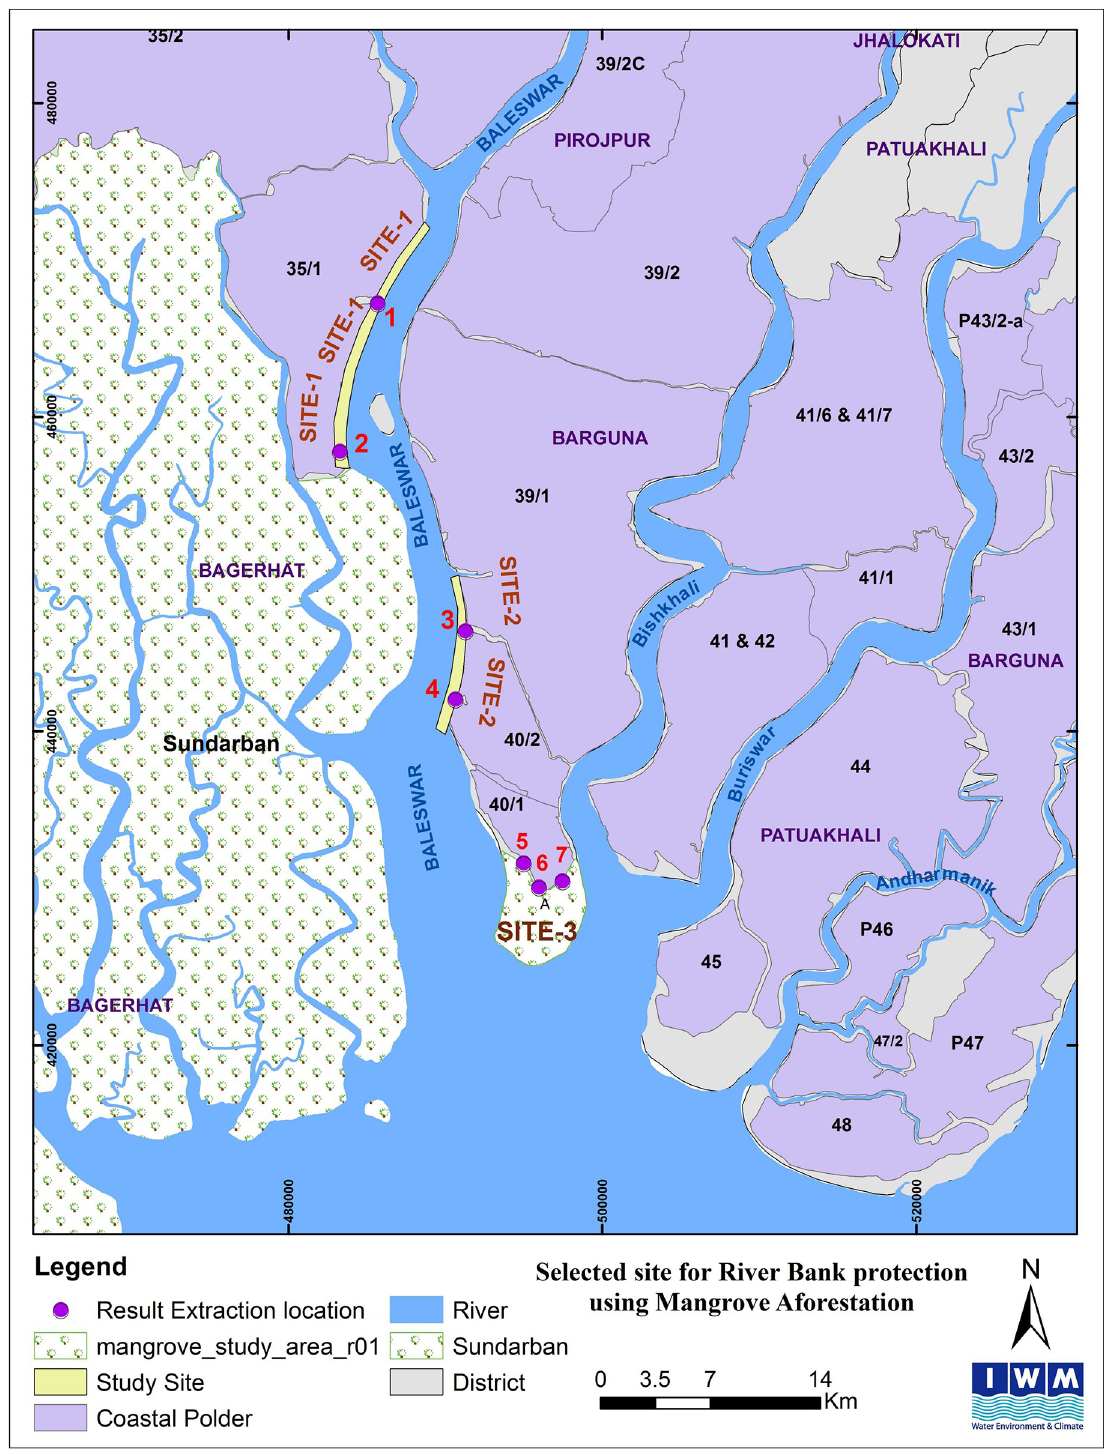
Fig 1. Three study areas, highlighting the seven sites for analysis.